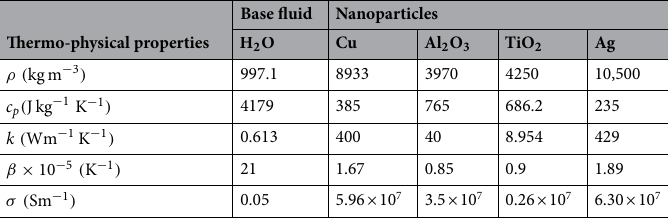
Table 1. Thermophysical properties of nanoparticles and base